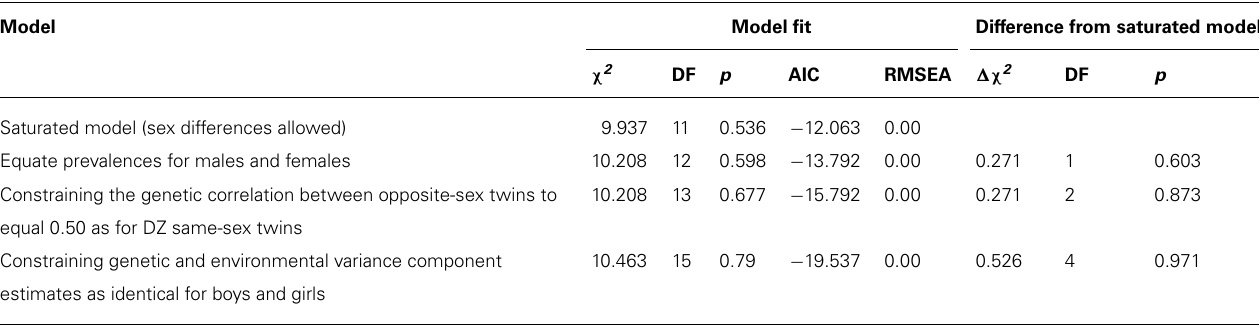
Table 2 |Tests for sex